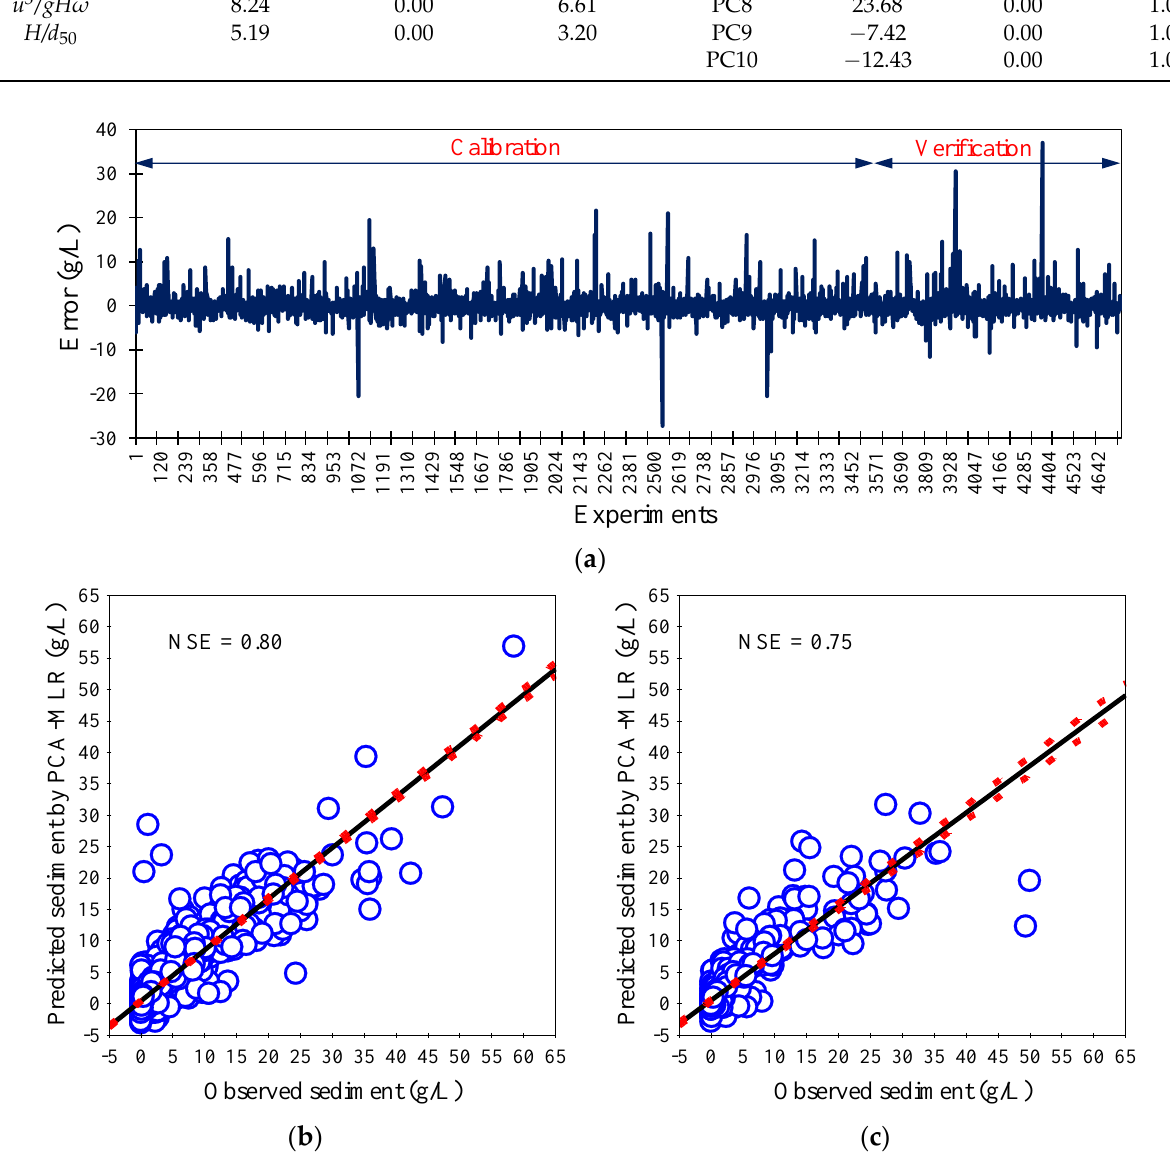
Figure 3. ( a ) The error between the sediment concentrations estimated by the PCA-based MLR model and those measured in laboratory flumes during both the calibration and verification steps. The scatter plots of the sediment concentrations estimated by the PCA-based MLR model and those values measured in laboratory flumes during the ( b ) calibration and ( c ) verification